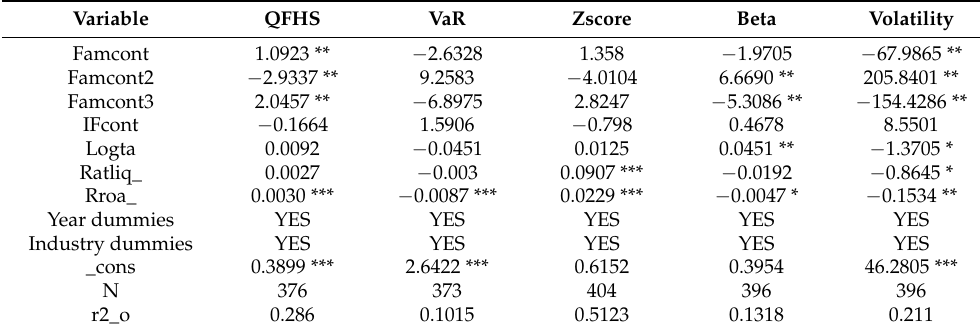
Table 11. Models considering ownership